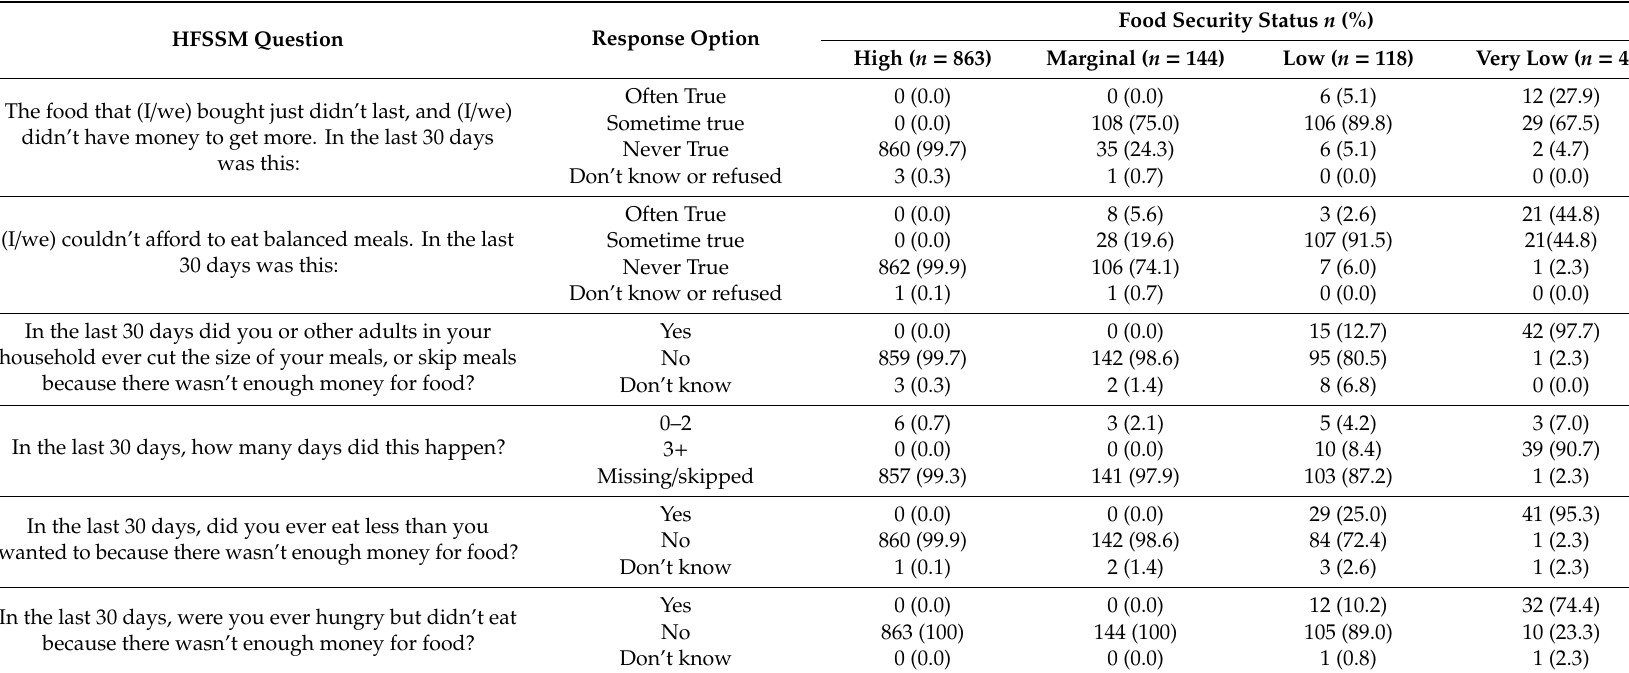
HFSSM—Household Food Security Survey